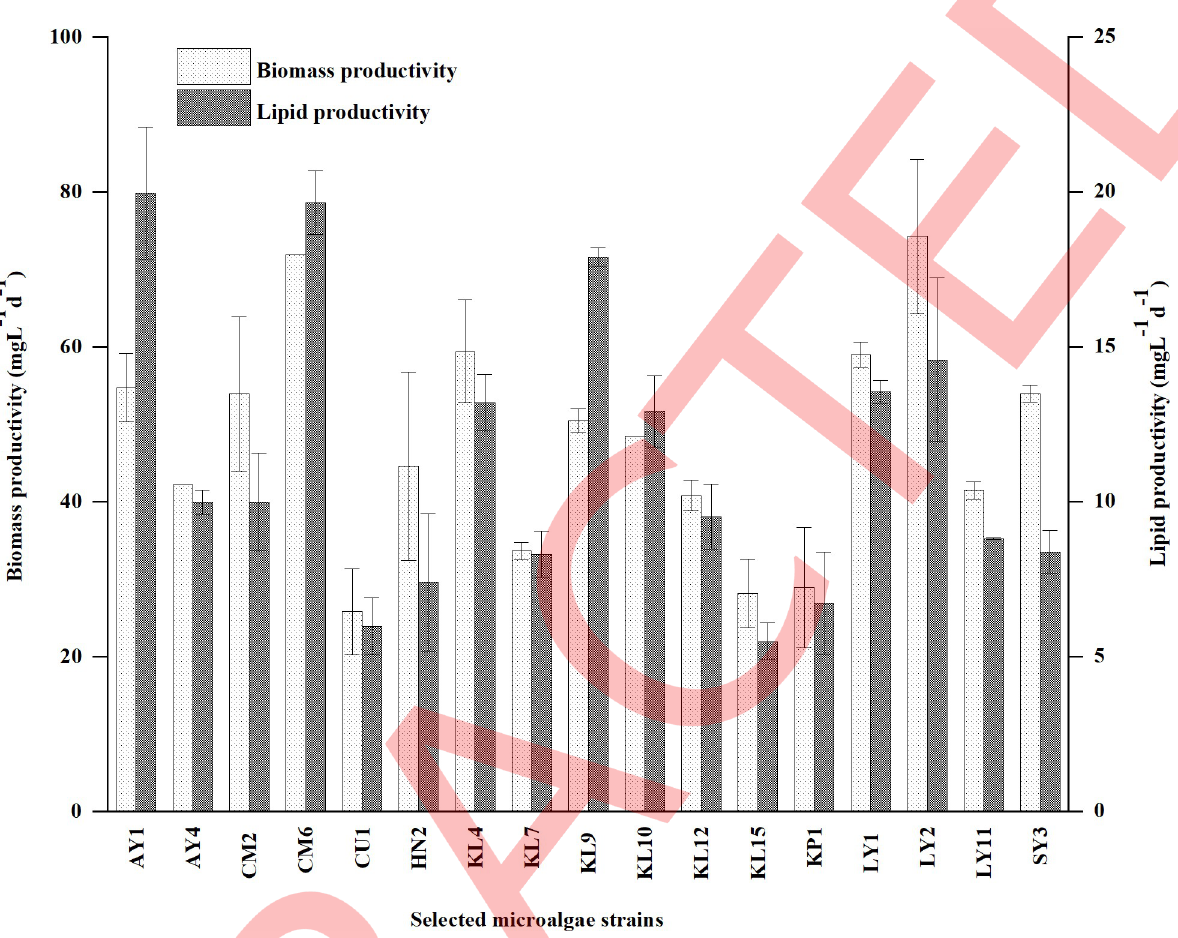
Fig 5. Biomass productivity and lipid productivity of the selected microalgae strains under mesophilic growth conditions. Error bars indicate standard deviations of the replicate values for each strain.